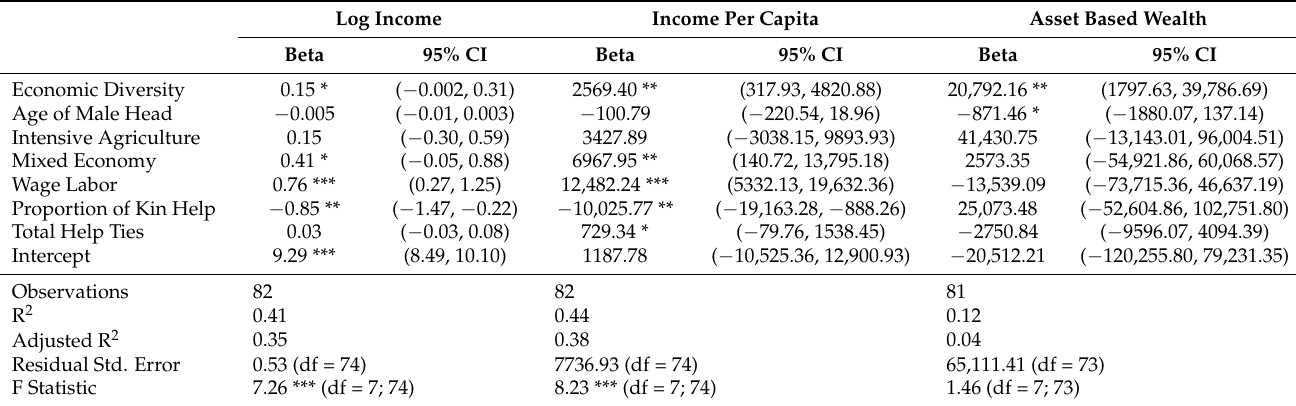
Table 4. OLS Regression Models Predicting Household Economic